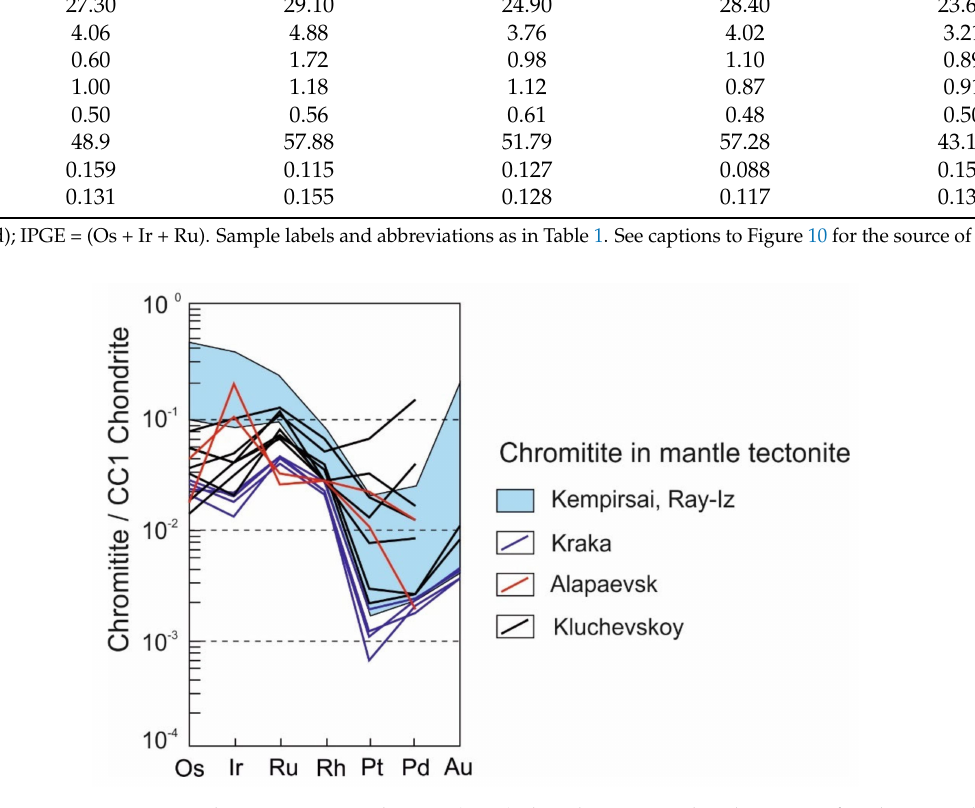
Figure 10. Platinum–group element (PGE) chondrite-normalized patterns for chromite deposits in the mantle tectonite of ophiolite complexes of the Urals (data source [25,48]). CC1 normalization data from